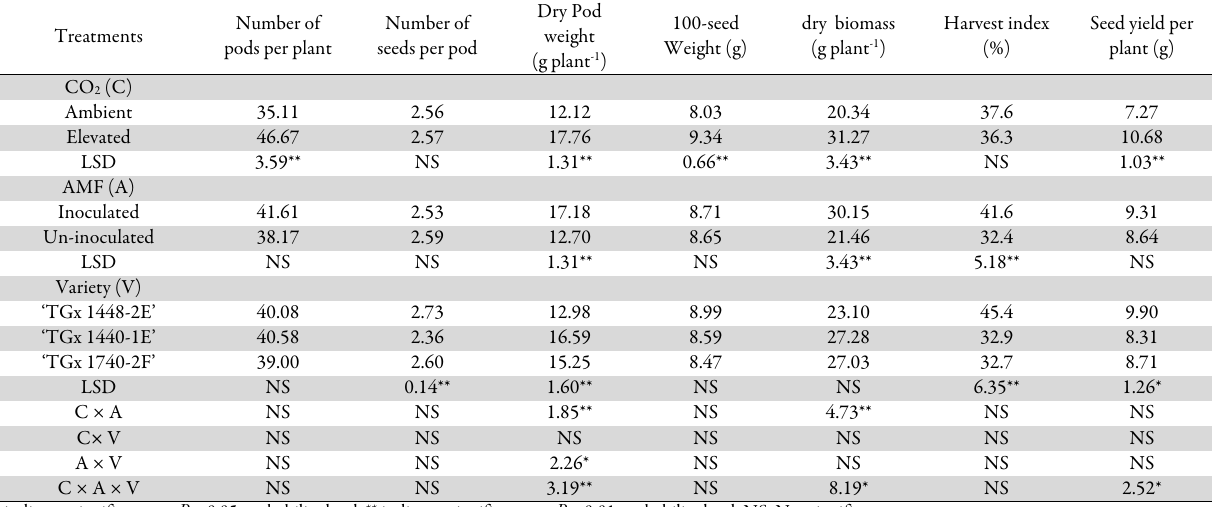
Table 2. Effect of CO 2 enrichment and AMF inoculation on number of pods, number of seeds per pod, dry pod weight, 100-seed weight, dry biomass, harvest index and grain yield per plant of soybean varieties at harvest maturity (pot experiment) Treatments